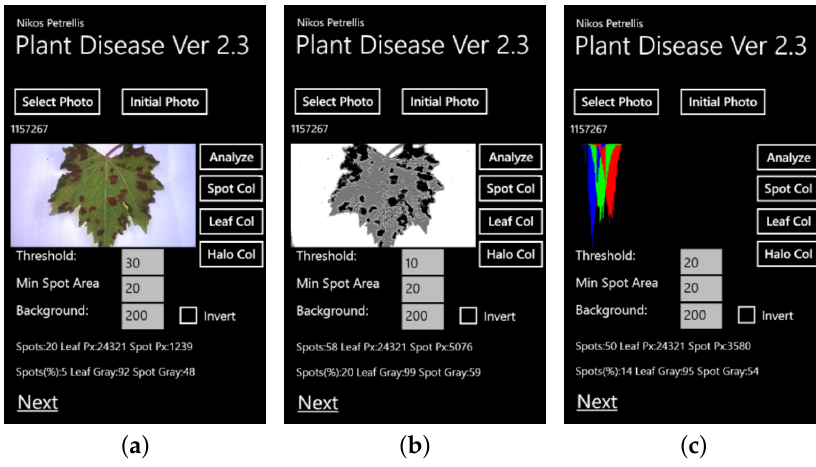
Figure 7. Plant Disease: ( a ) Original grape leaf photo; ( b ) Displaying the BGW1 matrix with Threshold equal to 10; ( c ) Color histogram of the regions affected by the